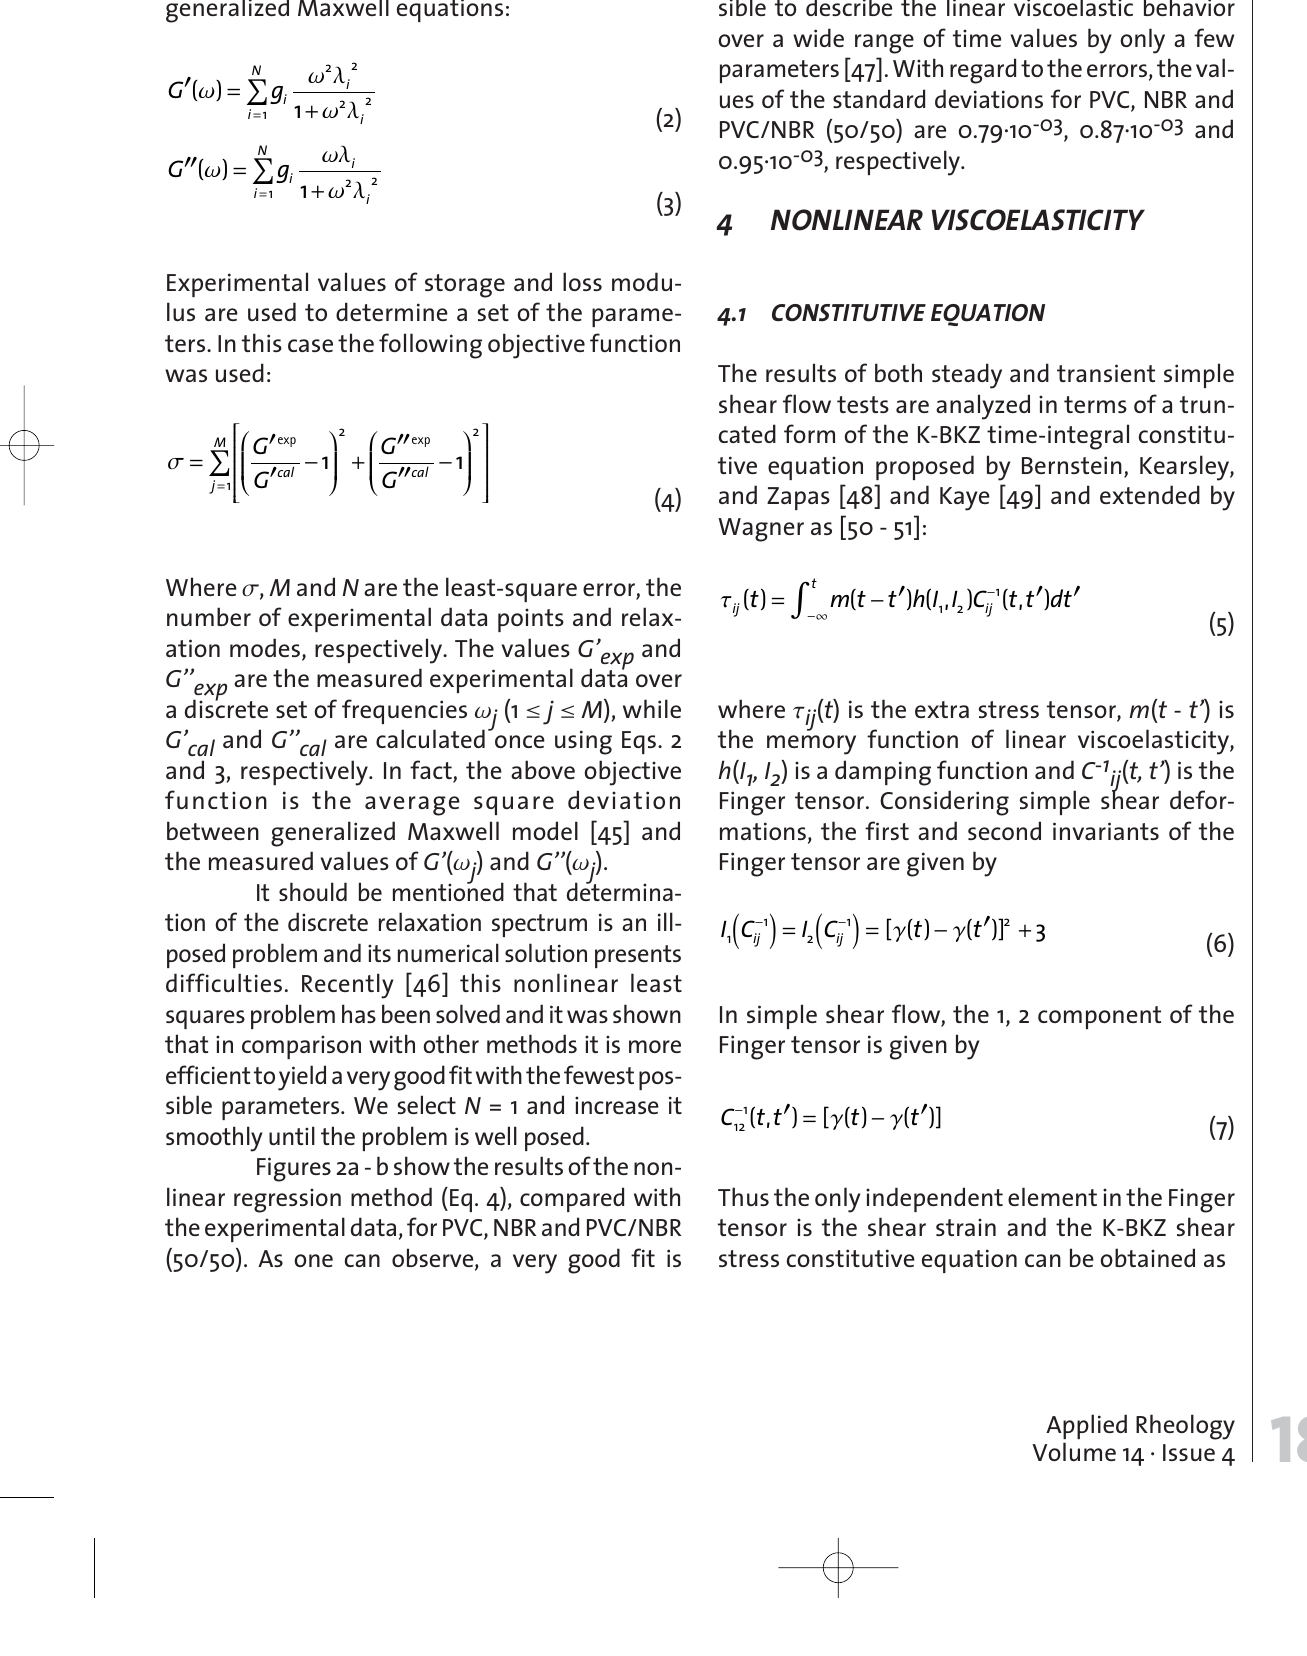
Table 2: Discrete relaxation spectrum for PVC, NBR, and PVC/NBR